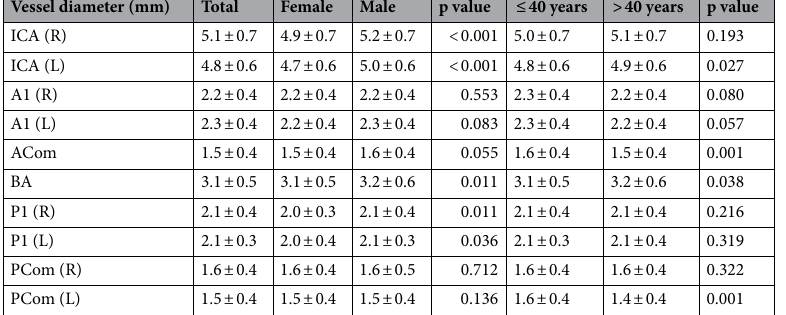
Table 4. Vessel diameters according to sex and